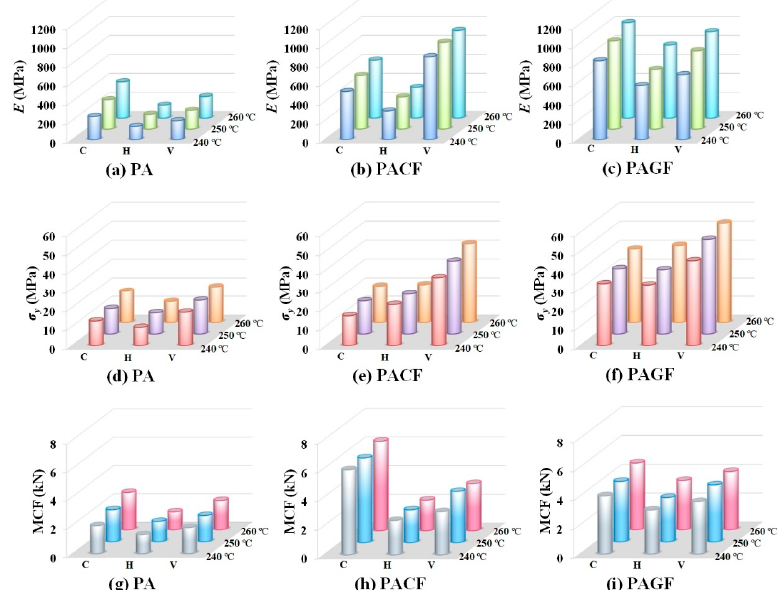
Figure 14. Elastic modulus of columns made of: ( a ) PA; ( b ) PACF; ( c ) PAGF; yield strength of columns made of: ( d ) PA; ( e ) PACF; ( f ) PAGF; and MCF of columns made of: ( g ) PA; ( h ) PACF; ( i ) PAGF.